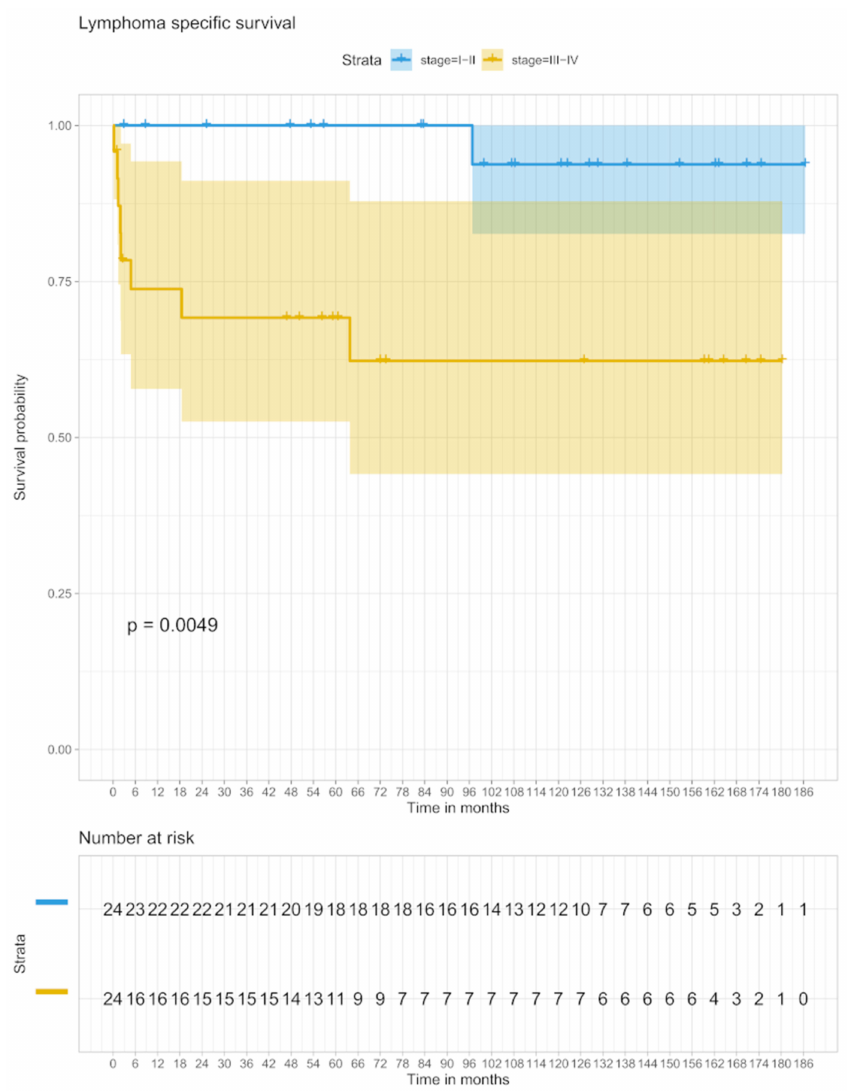
Figure 4. LSS in stage I/II and stage